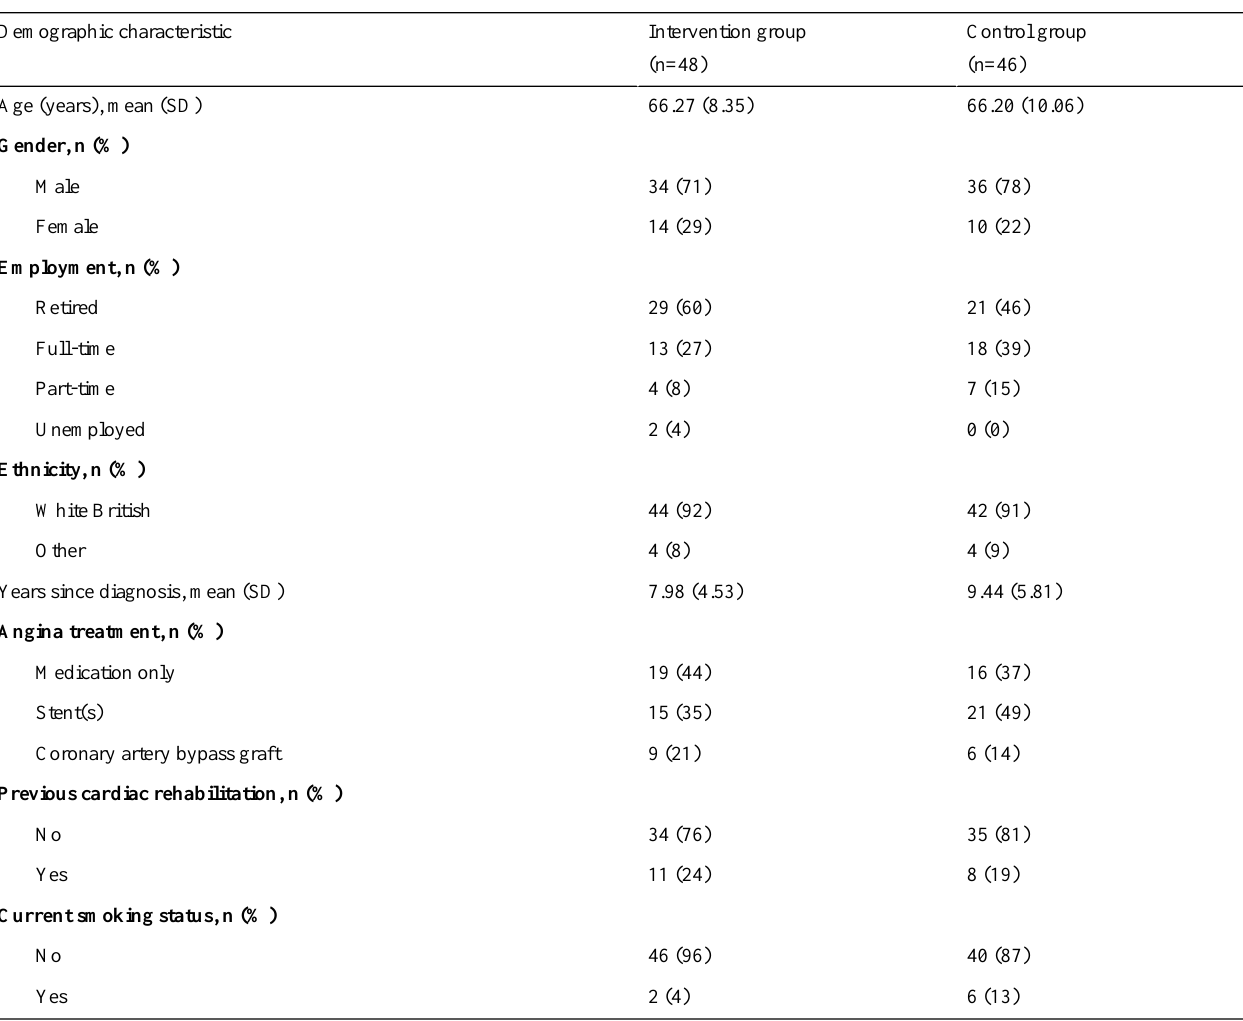
Table 1. Demographic characteristics of